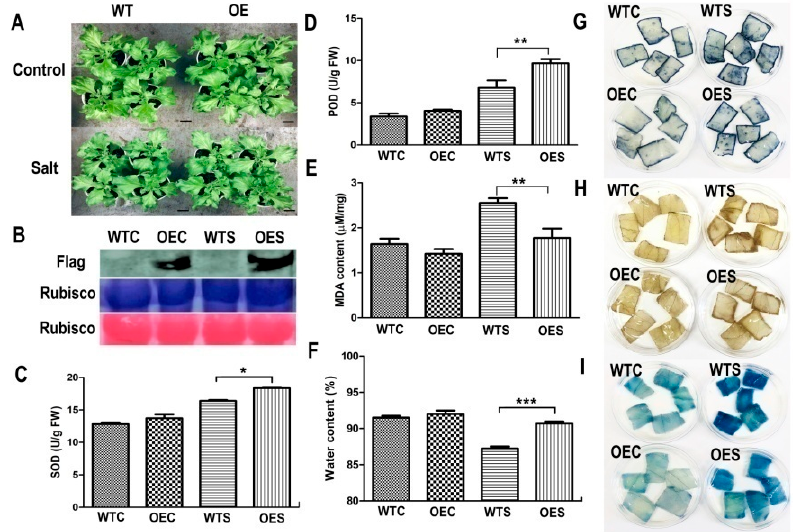
Figure 5. McHB7 -overexpressing (OE) plants under control and salt stress conditions. ( A ) Phenotype of OE plants and WT under control and salt stress conditions, bar = 2 cm. ( B ) Validation of OE plants after salt stress treatment. The OE plants were at day 14 after transformation; Student’s t -test, * p < 0.05, ** p < 0.01, *** p < 0.001. Error bars indicate mean ± SD ( n = 4). ( C ) SOD activity of OE plants and WT under control and salt stress conditions. ( D ) POD activity. ( E ) MDA content. ( F ) Water content. ( G ) NBT staining. ( H ) DAB staining. ( I ) Evans blue staining. WTC, WT under control conditions; OEC, transgenic plants under control conditions; WTS, WT after salt stress treatment; OES, transgenic plants after salt stress